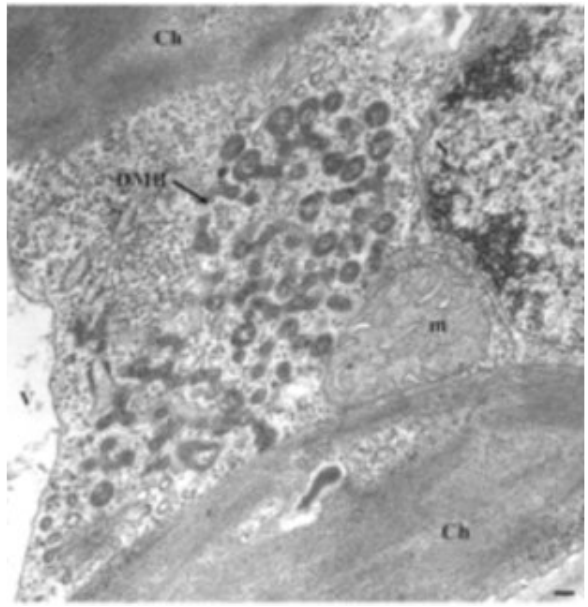
Figure 3. Groups of Double-Membraned Bodies in the cy- toplasm of mesophyll cells from a naturally infected fig. Arrows point to the aggregates of convoluted electron- dense double membrane elements. Ch: chloroplast; m: mi- tochondrion; N: nucleus; V: vacuole. Bar = 100